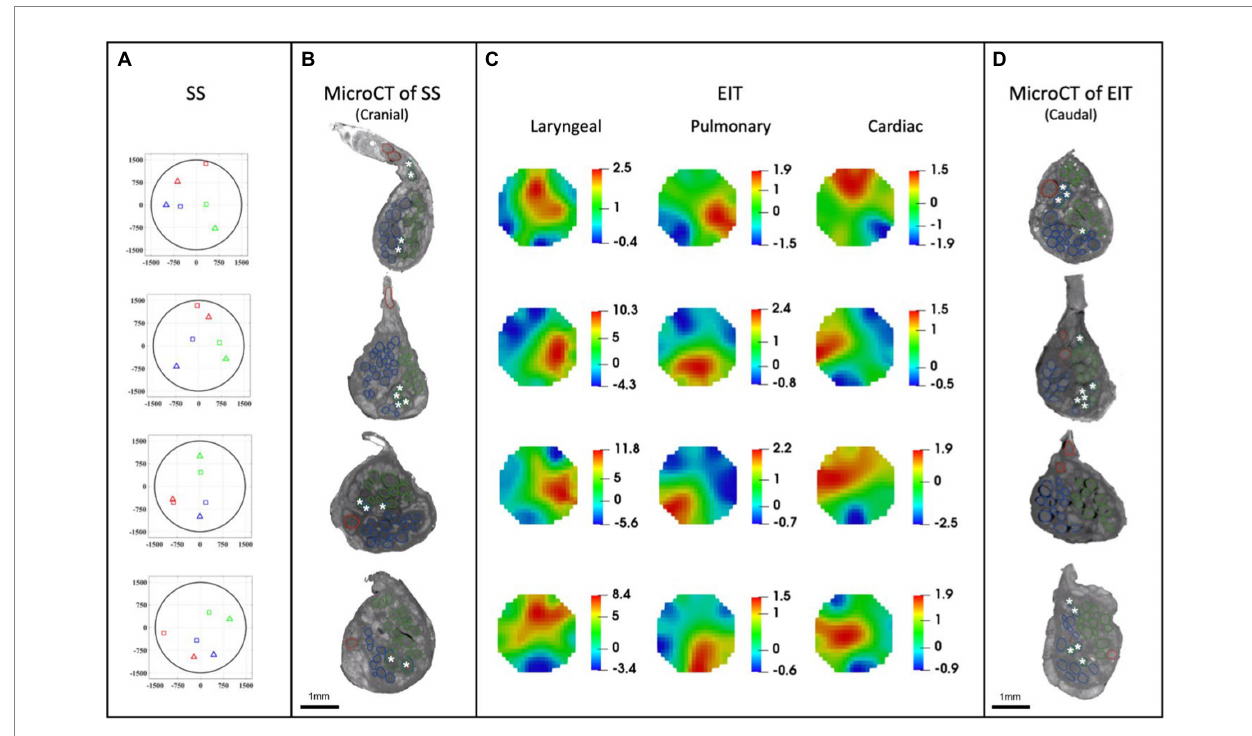
FIGURE 7 EIT, SS and microCT results ( N = 4) rotated with respect to the cuff opening (top; laryngeal in green, pulmonary in blue, and cardiac in red). (A) Selective stimulation (SS) CoM plots. Triangles = SS, Squares = microCT. For each plot, CoM location identified by SS is reported over a circular cross-section with 3 mm diameter, expressed in figure as ±1,500 μ m on both axes. (B) MicroCT cross-sections of the center of SS cuff with segmented fascicles. Merged pulmonary and recurrent laryngeal fiber-containing fascicles are demarcated with a white asterisk. (C) EIT images for each fascicular group in the nerves. The color scale is arbitrary units (Z score of relative change in the modulus of the impedance). (D) MicroCT cross-sections of the center of EIT cuff with segmented fascicles. Merged pulmonary and recurrent laryngeal fascicles are demarcated with a white asterisk. (A–D) rotated with respect to the cuff opening at 12 o’clock which corresponds with the ventral direction in the